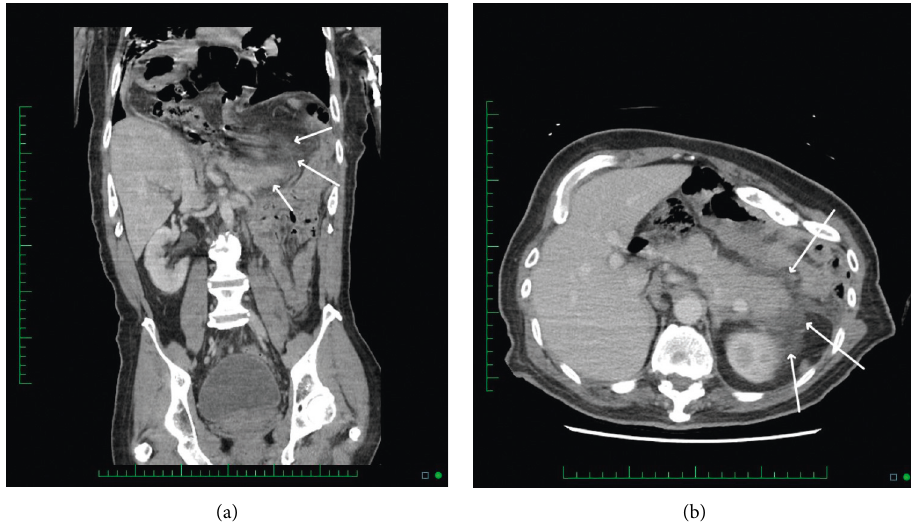
Figure 1: Coronal image (a) showing the peripancreatic inflammation (white arrows) in the LUQ around the tail of the pancreas. Axial image (b) showing the inflammation with the edematous appearance of the pancreatic body and tail (the brighter structure that the arrows are pointing